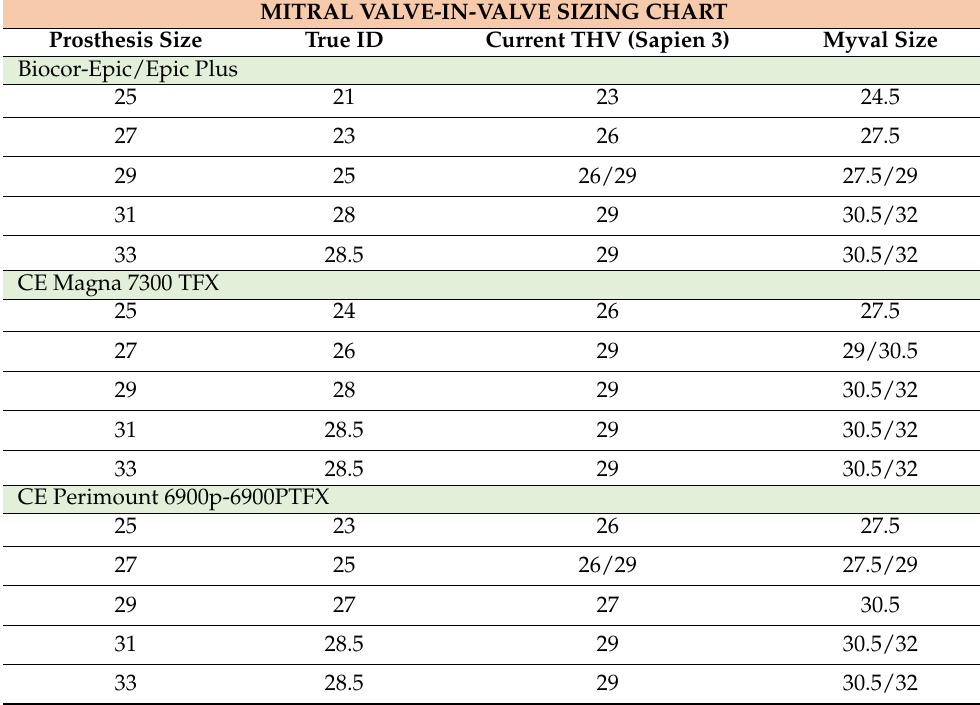
Table 3. Suggested valve sizing of Myval device for mitral valve-in-valve